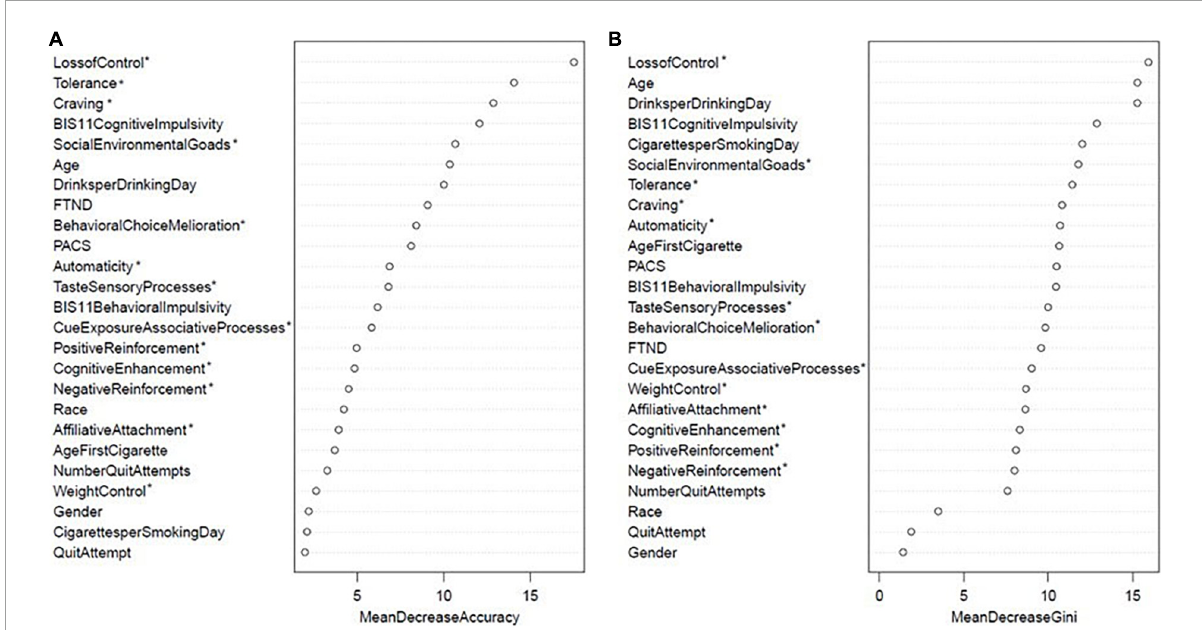
FIGURE1 Random forest variable importance: (A) Mean decrease accuracy and (B) mean decrease gini scores for one seed. Variables with an asterisk indicate 13 subscales of the WISDM-68.